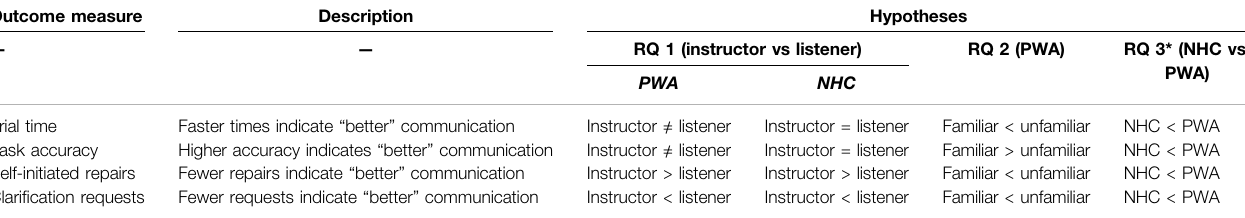
TABLE 2 | Hypotheses for each outcome measure, shown for each research question